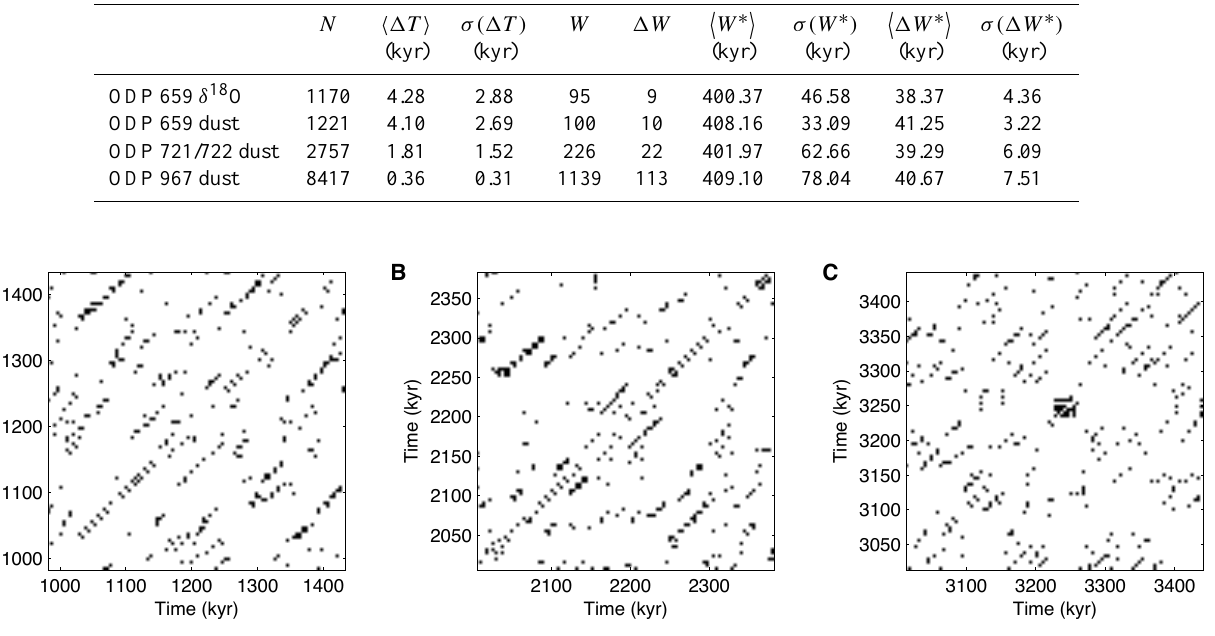
Fig. 5. Recurrence plots (equivalently adjacency matrices of the RNs shown in Fig. 6) obtained from the dust flux record at ODP site 659, centred around (A) 1.2, (B) 2.2, and (C) 3.2 Myr BP, using window size W ∗ = 410 kyr, step size ∆ W ∗ = 41 kyr, and embedding parameters